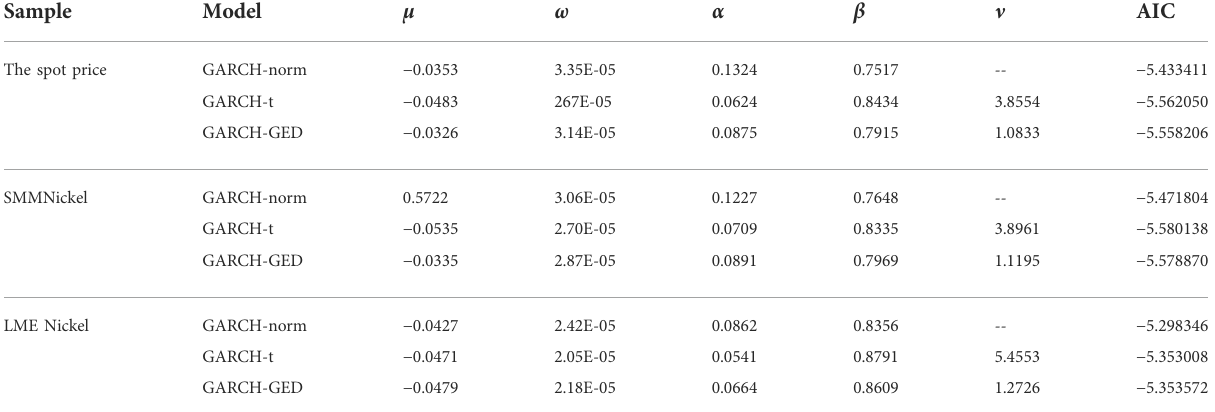
TABLE 4 Parameter estimation and test results of the marginal distribution model.